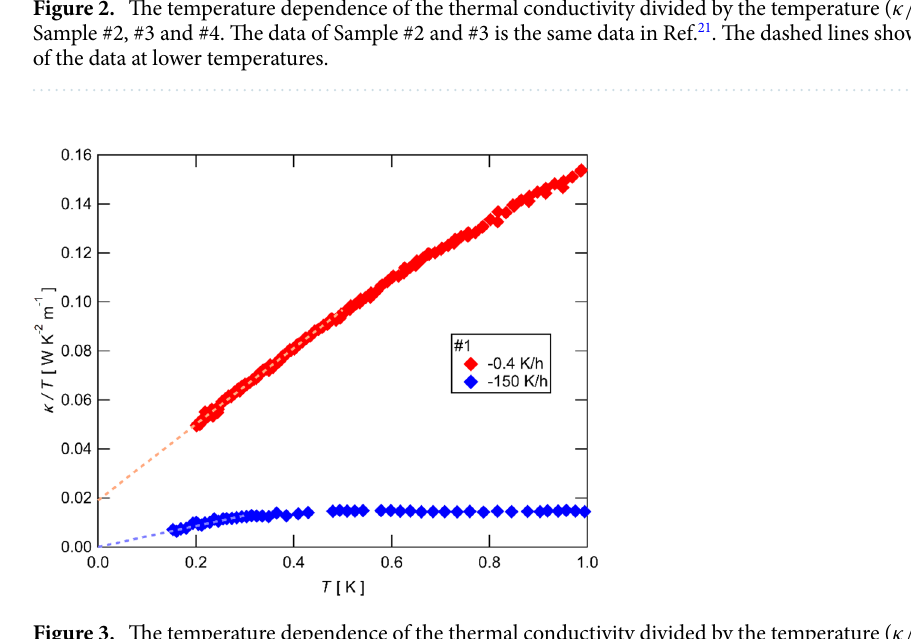
Figure 3. The temperature dependence of the thermal conductivity divided by the temperature ( κ/ T ) of Sample #1. The data of the first (− 0.4 K/h) and the second (− 150 K/h) cooling process is shown by the red and the blue symbols, respectively. The data of the first cooling of Sample #1 is the same data in Ref. 21 . The dashed lines show a linear extrapolation of the